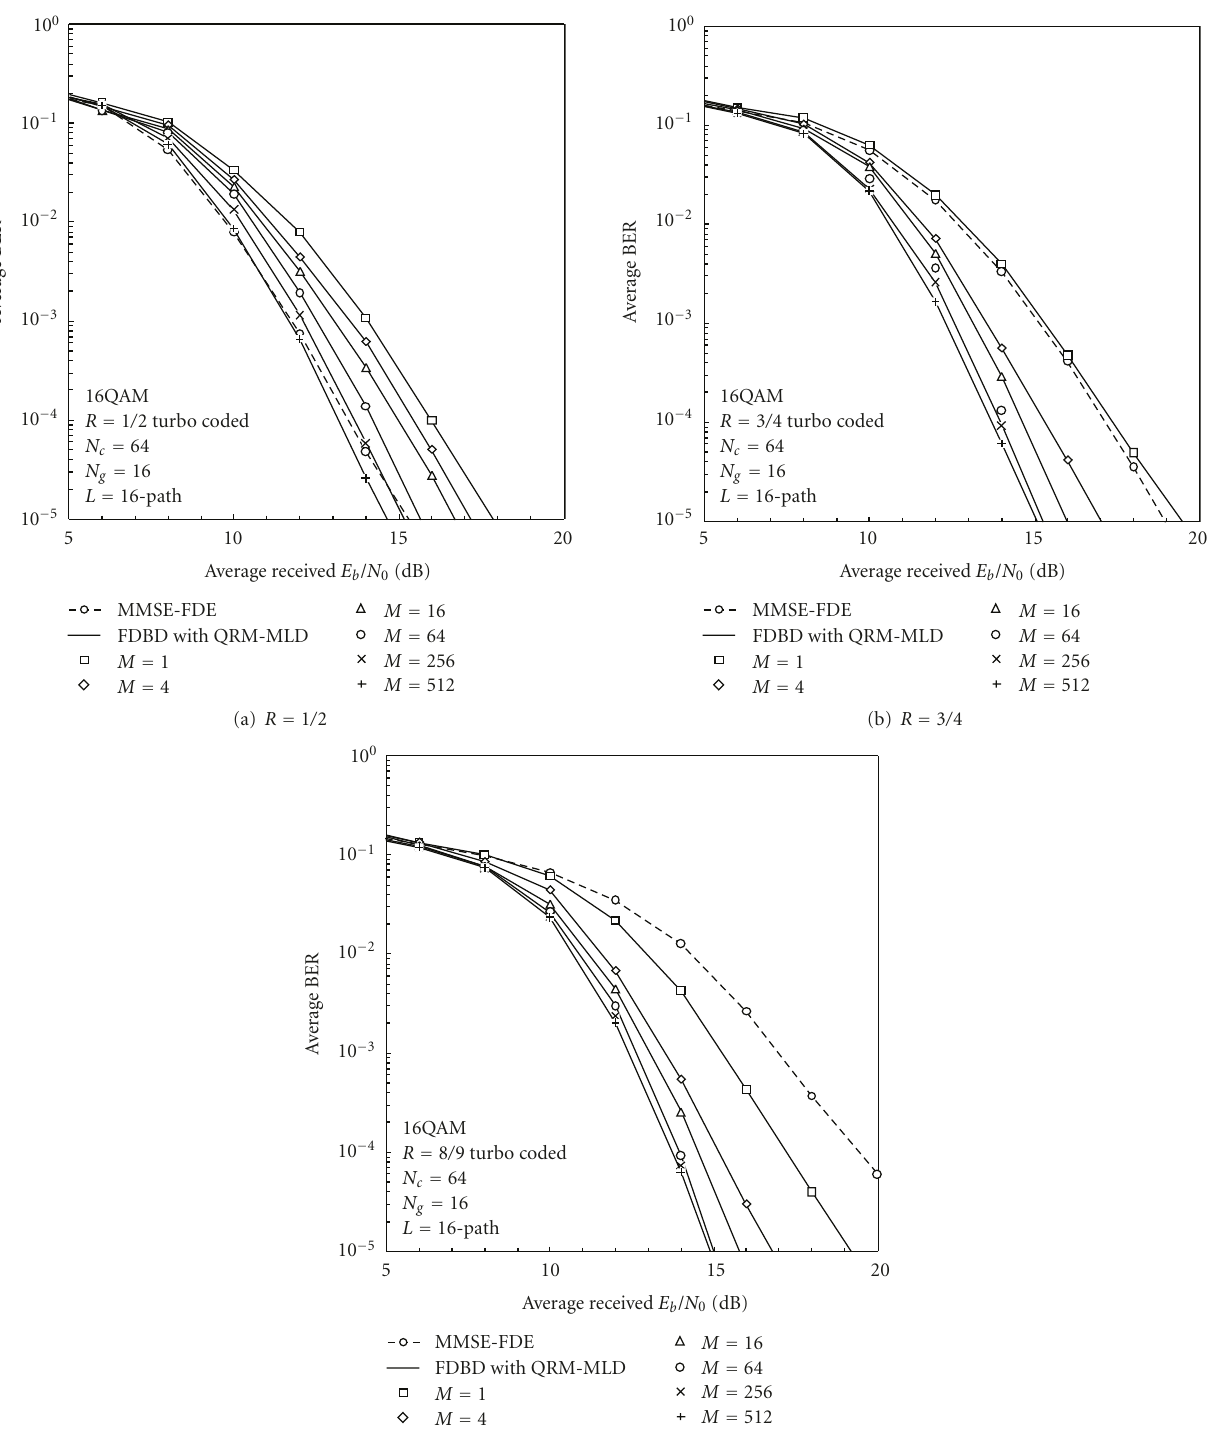
Figure 11: BER performance comparison between FDBD with QRM-MLD and MMSE-FDE in turbo-coded TA-SC.